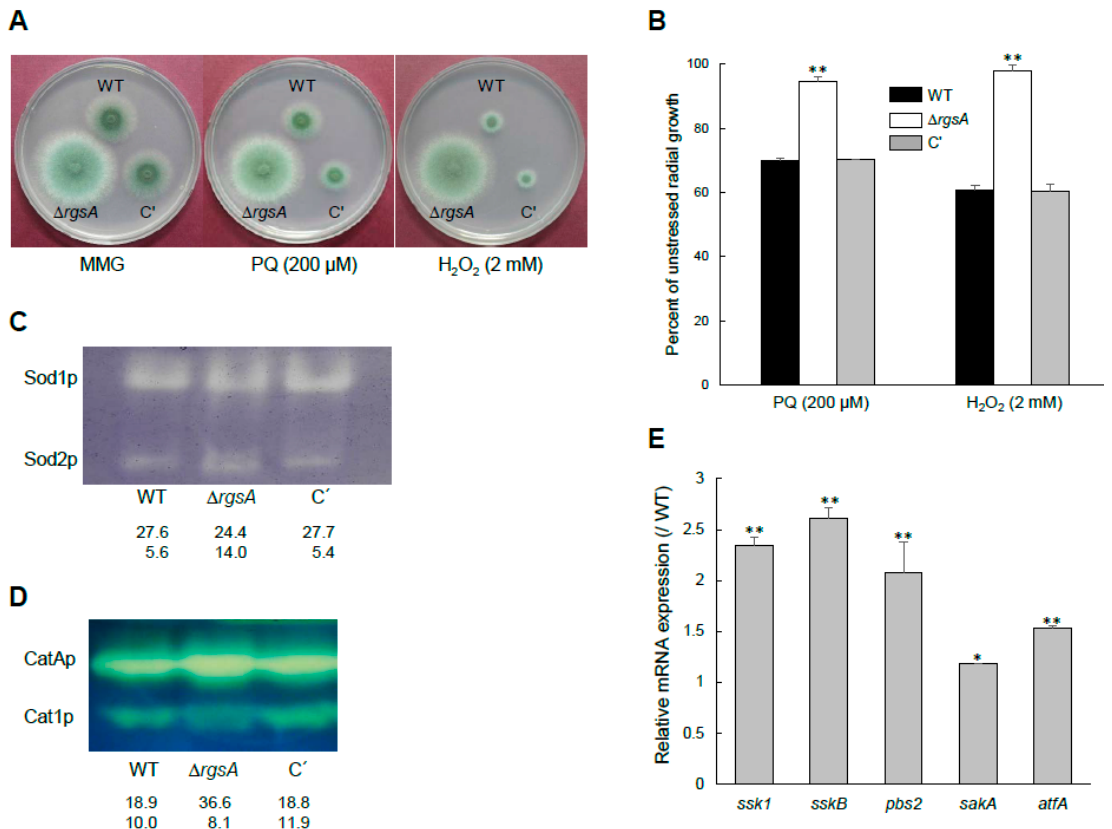
Figure 3. RgsA’s functions in the oxidative stress response. ( A ) Colony appearance after point inoculation of 1 X 10 5 conidia on solid MMG with oxidative stressors. ( B ) Quantification of growth inhibition was measured by colony diameters after 48 h of incubation at 37 ◦ C. ( C ) SOD activity in WT, ∆ rgsA , and C (cid:48) strains shown in non-denaturing polyacrylamide gels. ( D ) Catalase activity in WT, ∆ rgsA , and C (cid:48) strains. Relative intensities of each enzyme are shown below. ( E ) Levels of stress-activated genes’ mRNA in three strains analyzed by qRT-PCR. Statistical significance was determined by ANOVA and a Student t -test: ** p < 0.01; * p <